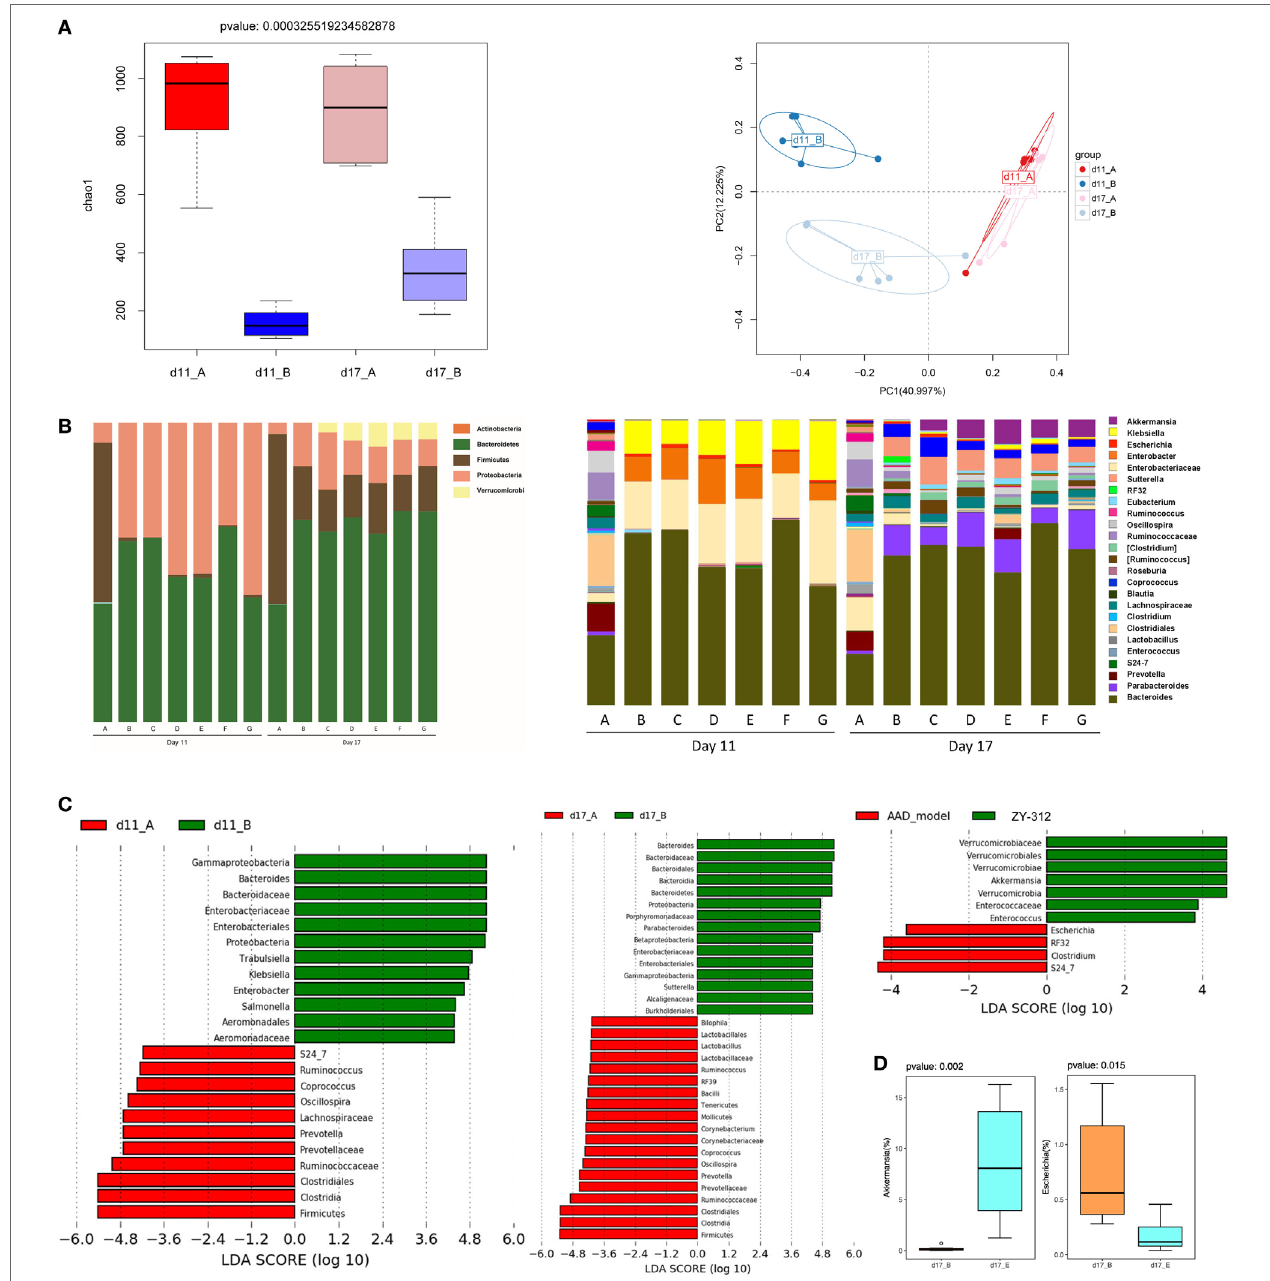
FigUre 4 | Bacteroides fragilis ZY-312 restores specific microbiota changes in antibiotic-associated diarrhea (AAD) rats. (a) Microbial richness based on the Chao1 index, and unweighted UniFrac principal coordinate analyses based on all operational taxonomic units (OTUs) of normal rats (group A) and AAD rats (group B) on days 11 and 17, respectively. (B) Relative abundance of OTUs of the gut microbiota in all groups, including normal control (group A) and AAD groups gavaged with normal saline (group B), different doses of ZY-312 (10 7 , 10 8 , and 10 9 CFU) (group C, D, and E), Bifico (70 mg/day) (group F), or Bifico (70 mg/day) combined with ZY-312 (10 8 CFU) (group G) by gavage, at the rank of phylum (left panel) and genus (right panel). (c) Linear discriminant analysis effect size identifies differential abundance of bacteria between normal rats (group A) and AAD rats (group B) on days 11 and17, or between AAD rats (group B) and ZY-312 (10 9 CFU) rats (group E) (LDA > 3.5), respectively. (D) Relative abundance of OTUs of the genus Akkermansia and Escherichia that are significantly altered by ZY-312 treatment (group